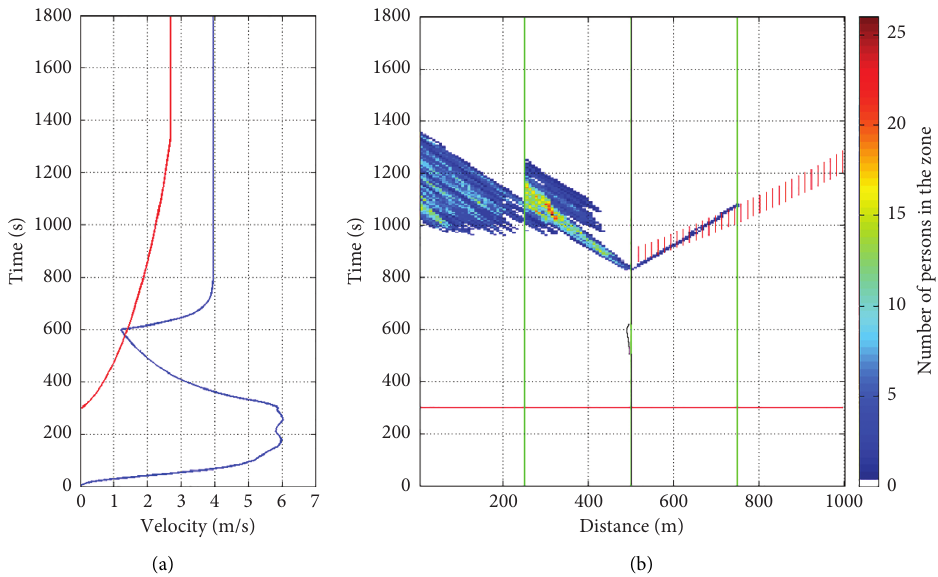
Figure 15: Course of evacuation for the truck fire with switched-on ventilation [36]. (a) Velocity of air flow. (b) Course of